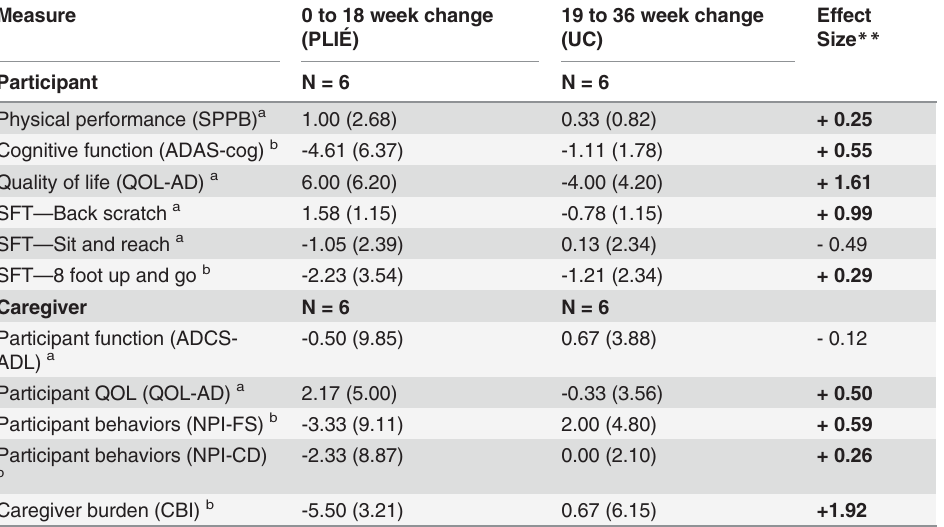
Table 5. Within-Group Changes * and Effect Sizes in Participant and Caregiver Measures, Group 1. Measure 0 to 18 week change